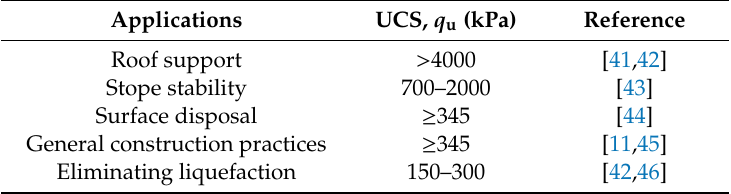
Table 5. Strength criteria for CPBs adopted in mining applications (modified from